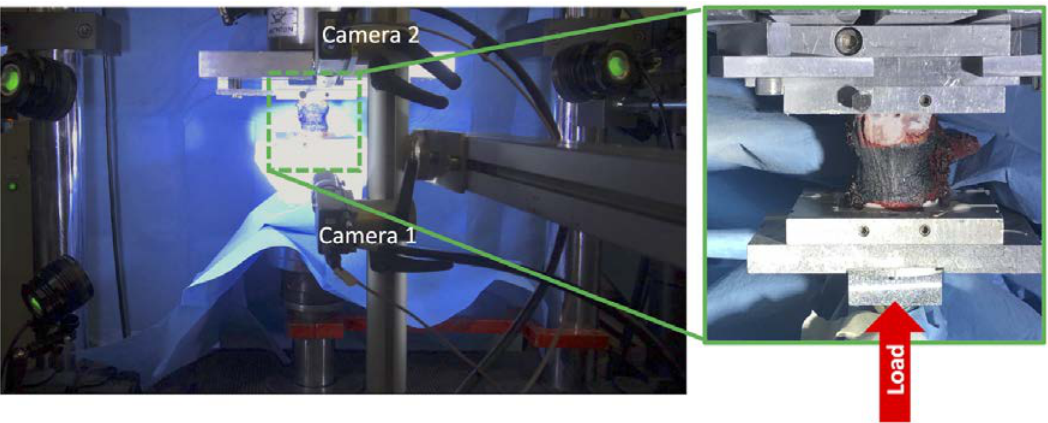
Figure 3. Left: loading setup with 3D-DIC cameras and light system. The low friction linear bearings and the ball joint are covered by the blue towels. On the right, a detail of the specimen with the speckle pattern (anterior view).